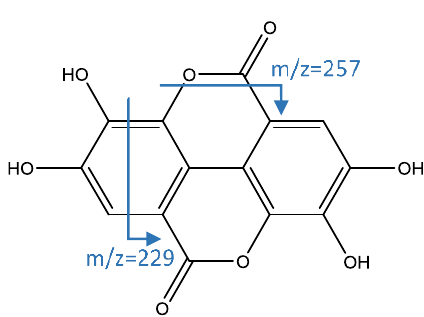
Figure 5. Structure and fragments of acid derivatives (35), (37) and (38).